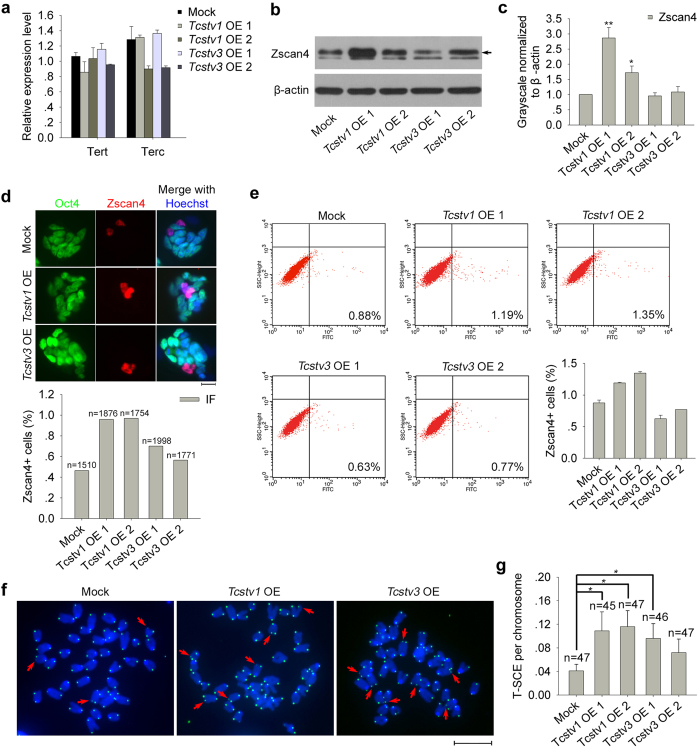
Tcstv1 or Tcstv3 overexpression enhances telomere sister chromatid exchange (T-SCE) in mouse ESCs and elevates Zscan4 protein levels.(a) Expression levels of Tert and Terc showed no significant difference among Tcstv1 OE, Tcstv3 OE and mock ESCs by qPCR analysis. Two repeated experiments with duplicated samples each. (b) Confirmation of Zscan4 protein levels in Tcstv1 OE, Tcstv3 OE and mock ESCs by western blot. Black arrow indicates Zscan4 bands. (c) Quantification of relative Zscan4 protein levels normalized to β-actin by ImageJ software. n = 4. (d) Immunofluorescence images of Zscan4 (red) and Oct4 (green) in Tcstv1 OE, Tcstv3 OE and mock ESCs (Scale bar = 20 μm), and proportion of Zscan4 positive cells. n, number of cells counted. χ2 test shows no statistical difference (P > 0.05). (e) Analysis of Zscan4+ cells in Tcstv1 OE, Tcstv3 OE and mock ESCs by flow cytometry. (f) Representative micrographs showing T-SCE (red arrows) by CO-FISH analysis. Scale bar = 10 μm. (g) T-SCE per chromosome in Tcstv1 OE, Tcstv3 OE and mock ESCs. n, number of cells counted. *P < 0.05, **P < 0.01, compared with controls.